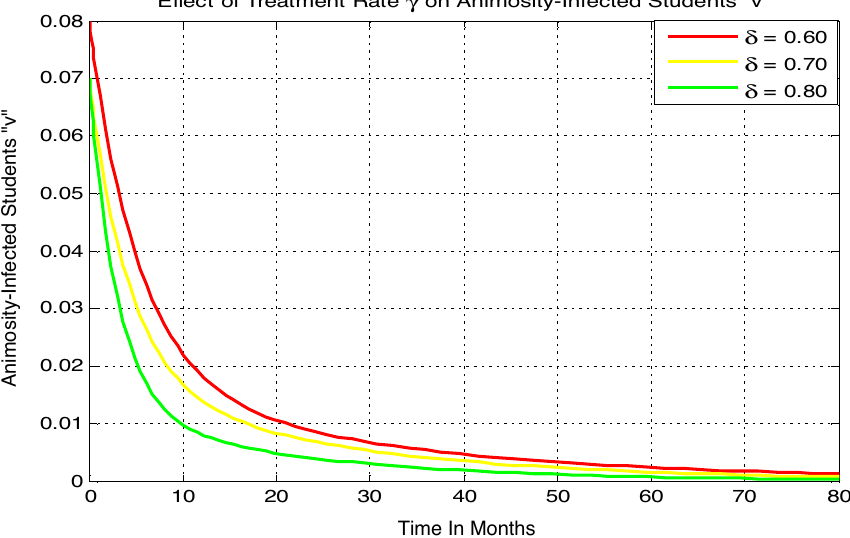
Figure 6. Effect of treatment rate δ on animosity-infected